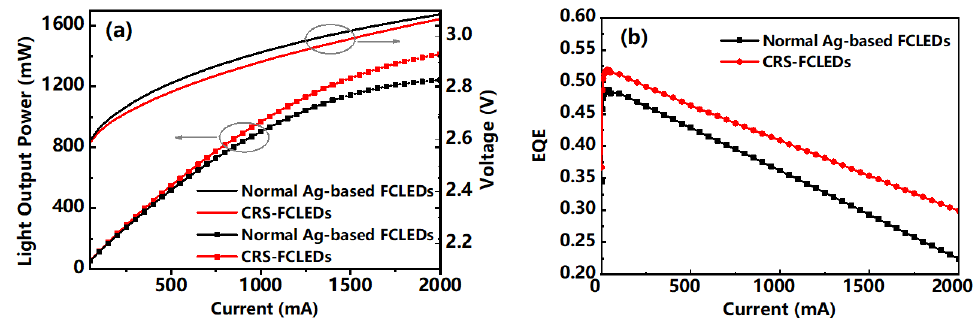
Figure 5. ( a ) Forward voltage and LOP versus injection current for normal Ag-based FCLED and CRS-FCLED. ( b ) EQE versus injection current for normal Ag-based FCLED and CRS-FCLED.